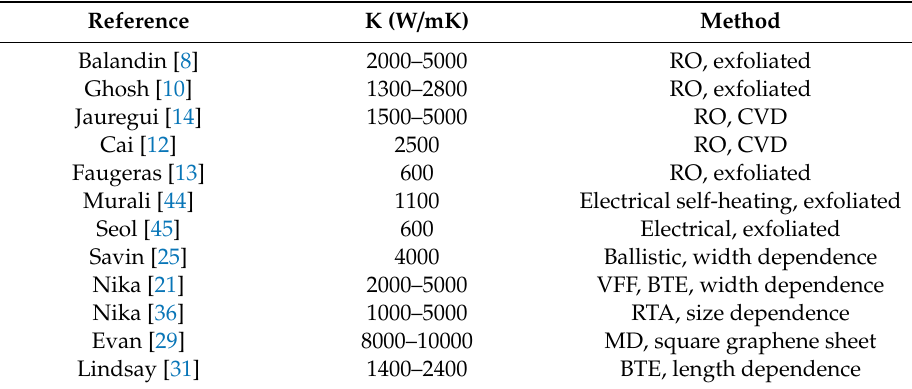
Table 1. Thermal conductivity of graphene in reference.